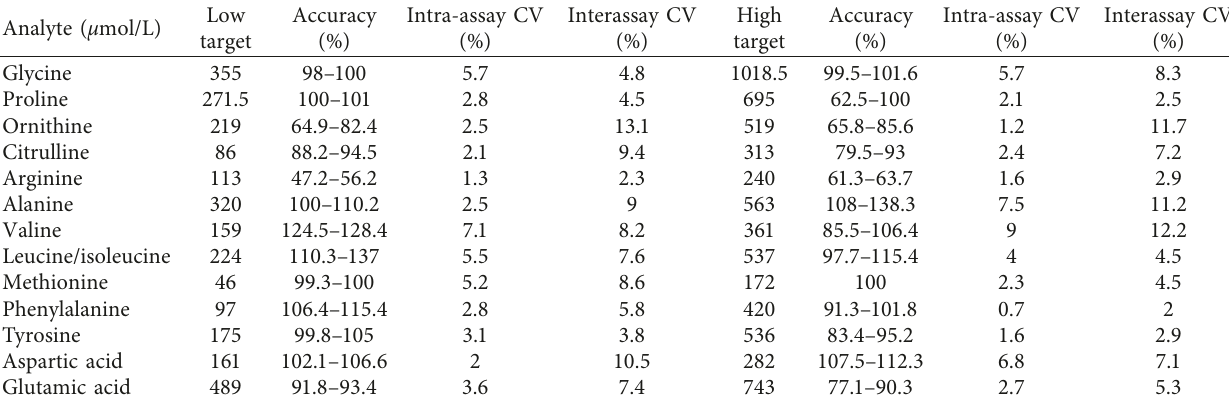
Table 4: Accuracy, intra-assay, and interassay CV (%) of each amino acid at two different concentrations. Analyte ( µ